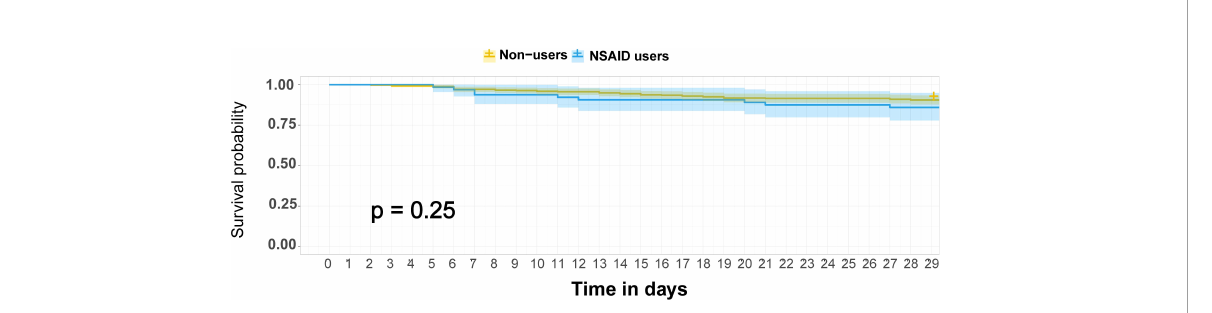
FIGURE 1 K-M survival curves for 28-day mortality among NSAID users and non-users among hospitalized patients with COVID-19. The survival curves are survival function (Kaplan – Meier) curves with a p -value calculated by the log-rank test. Patients were followed up for death until 28 days after randomization in ORCHID using in-hospital records and telephone follow-up. COVID-19, coronavirus disease 2019; ORCHID, Outcomes Related to COVID-19 Treated With Hydroxychloroquine Among Inpatients With Symptomatic Disease; K-M, Kaplan – Meier; NSAID, non-steroidal anti-in fl ammatory drug.